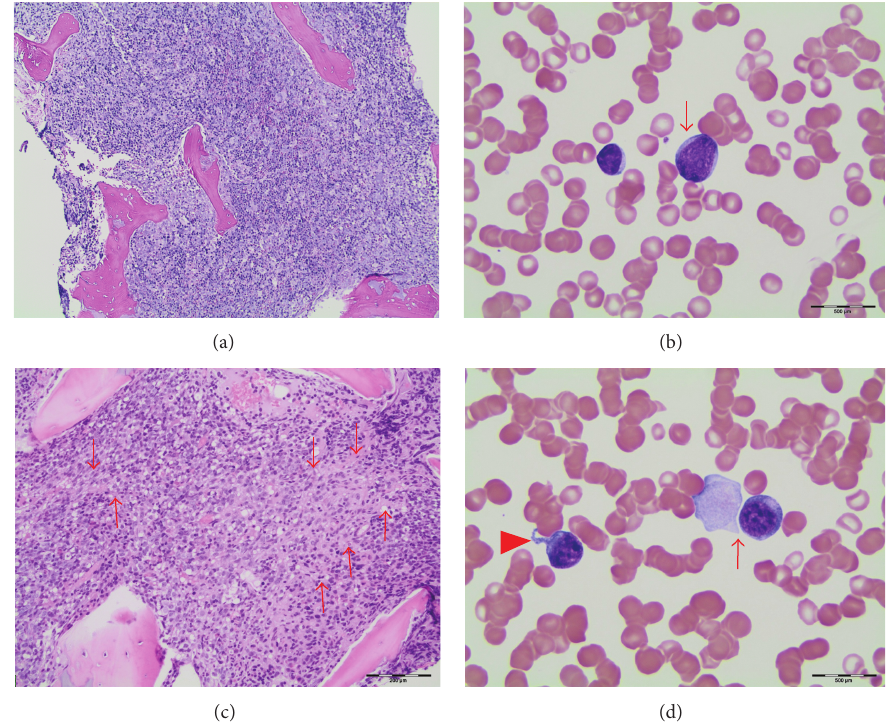
Figure 1: (a) Bone marrow core biopsy showing high cellularity with marrow space occupied mainly by early myeloid cells. (b) Most blasts are nondescript, medium-sized with scanty blue cytoplasm and small nucleoli. (c) Collagen bands (arrows) are evident in areas of core biopsy. (d) Some blasts showed megakaryocytic features with cytoplasmic blebs (arrowhead) or platelet-like pseudopods